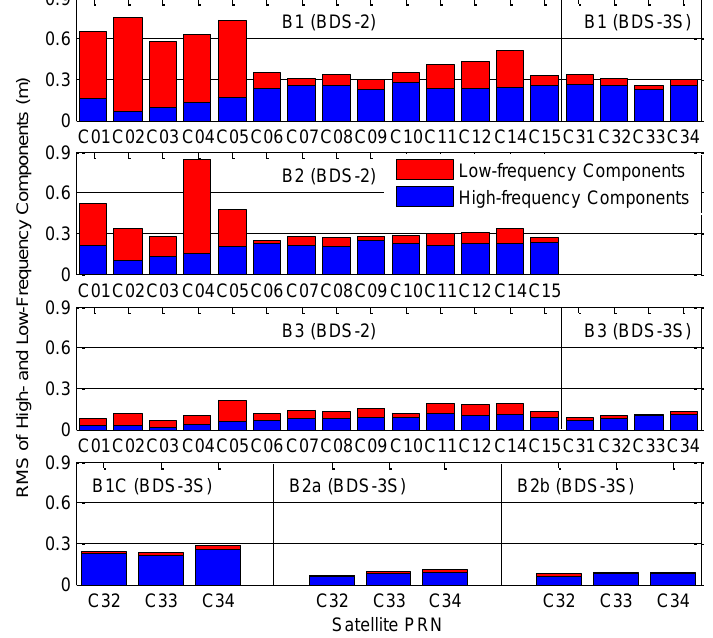
Figure 8. RMS statistics of high- and low-frequency components in the time series of MP combinations at station